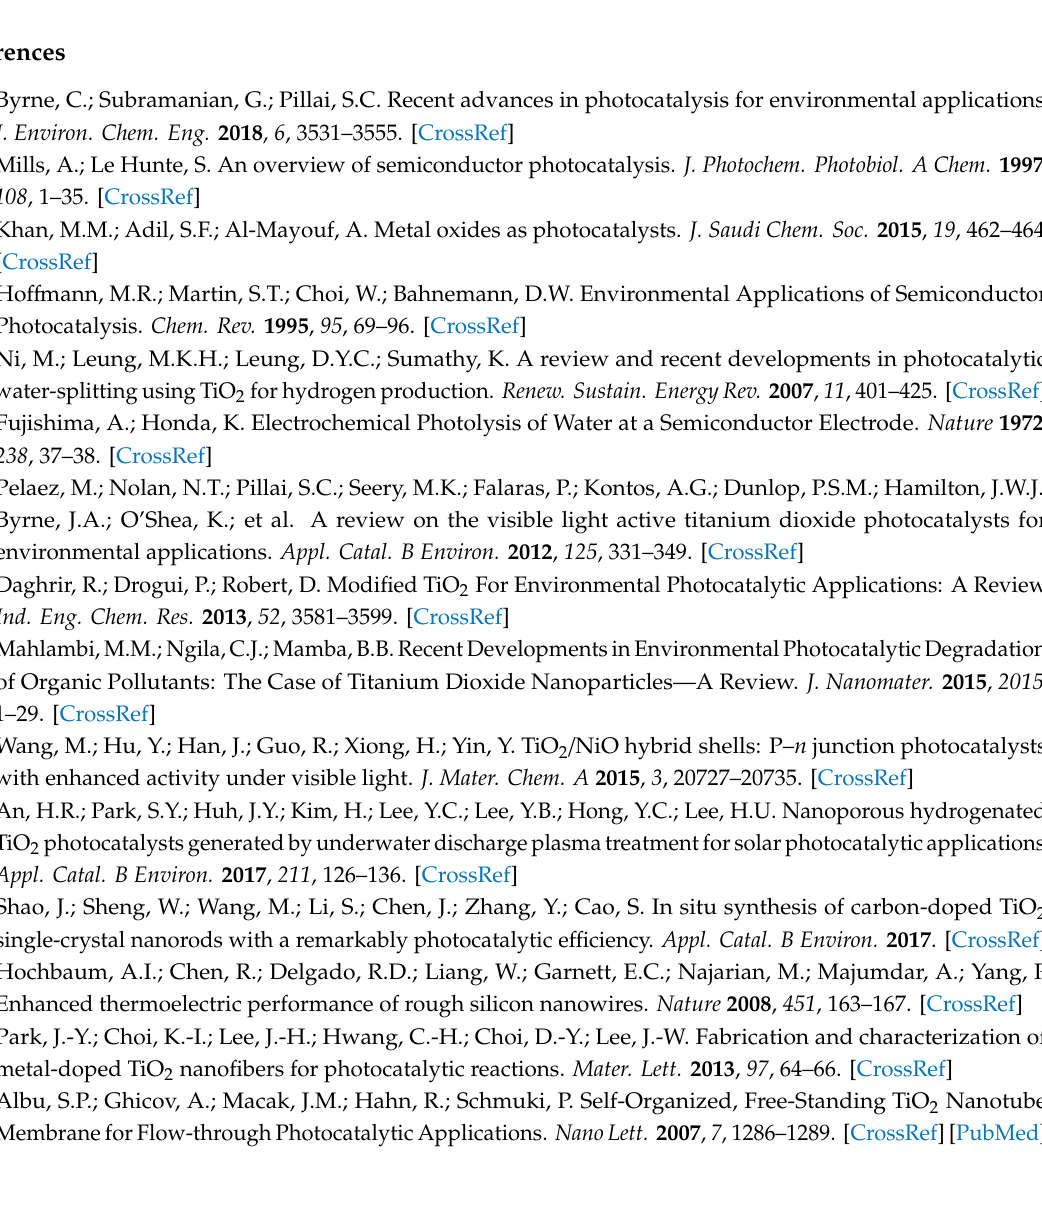
Figure S1: XRD peak observed in the range of 2-theta = 71–74 ◦